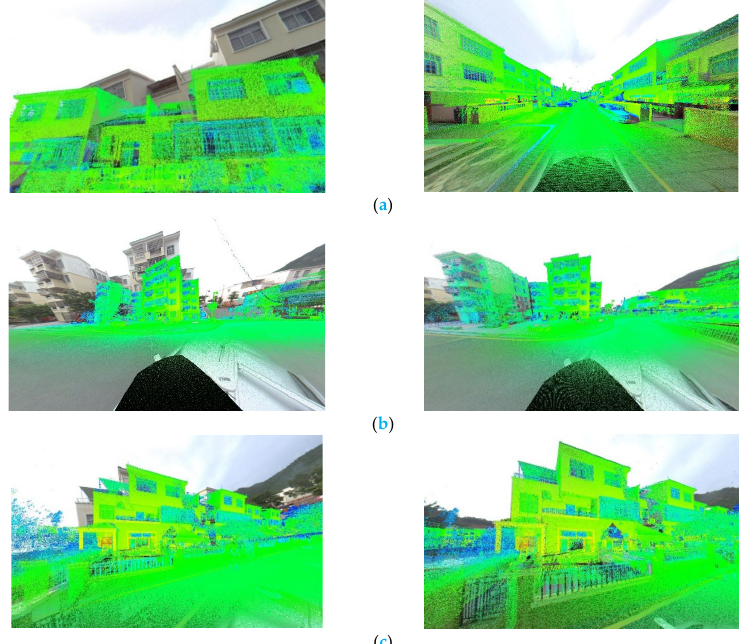
Figure 13. Effect diagram before and after registration. ( a ) comparison of the first test data before and after registration; ( b ) comparison of the second test data before and after registration; ( c ) comparison of the third test data before and after registration. Table 9. Optimization of the exterior orientation parameters: the (Initial value) column represents the initial value of the element, the (Correct value) column represents the correct value of the element, and the (Final value) column represents the final optimized value of the element.